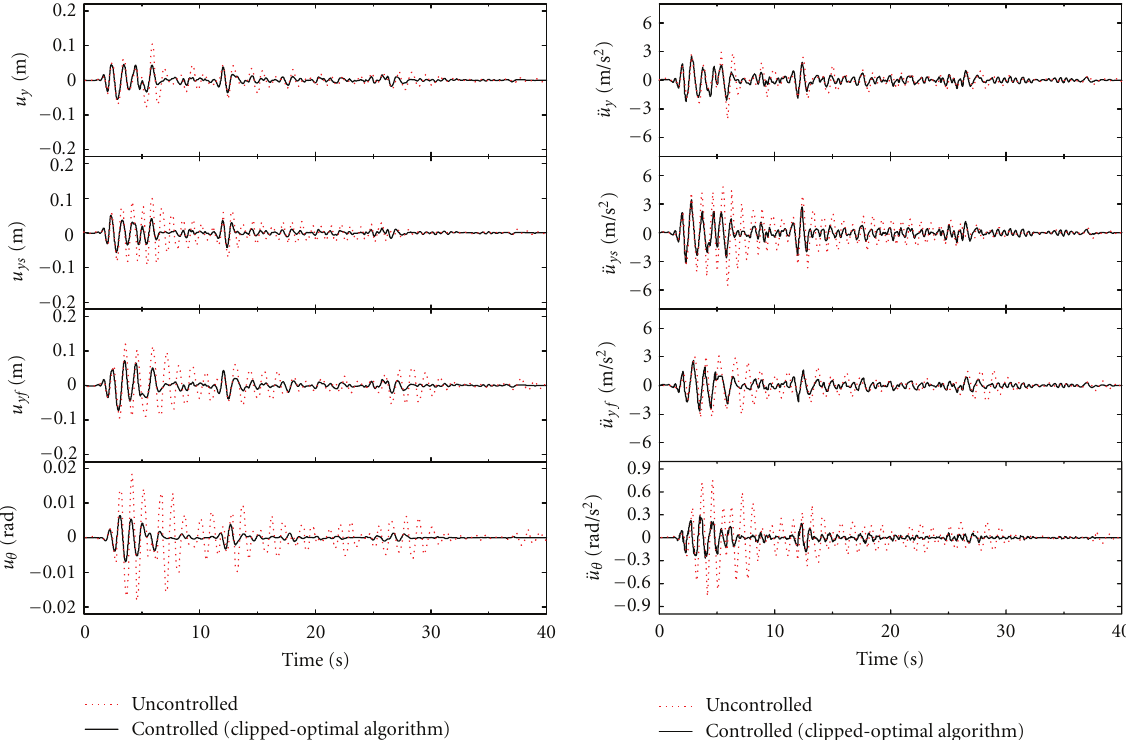
Figure 5: Time histories for various uncontrolled and controlled displacements and accelerations under Imperial Valley, 1940 earthquake ( T y = 1s, Ω θ = 1, e x / r = 0 .